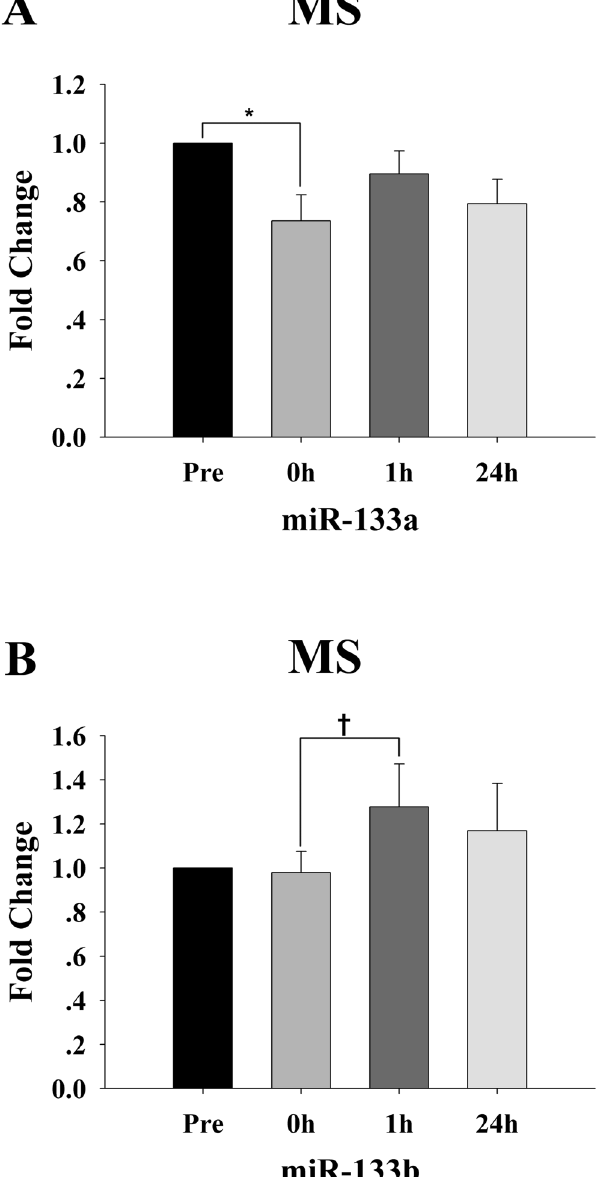
Figure 6. Time-course changes in the plasma levels of miR-133a ( A ) and miR-133b ( B ) for the maximum strength (MS) protocol (n = 15). For each subject, the c-miRNA levels at baseline (Pre) were assigned a fold change of 1, and measurements obtained immediately after exercise (0 h), after 1 h of recovery (1 h) and after 24 h of recovery (24 h) were compared to the baseline. * Indicates differences compared to Pre, p < 0.05; † indicates differences compared to 0 h, p < 0.05. Values represent the mean ±